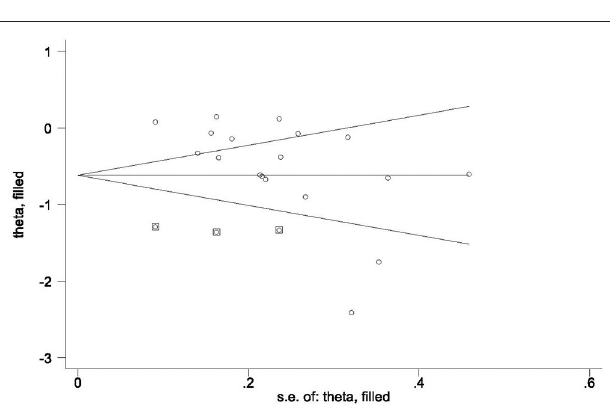
FIGURE 4 | Filled funnel plot to access potential publication bias of the negative affect studies ( n = 18). The circle and square with circle inside represent observed data (18 comparisons) and data added (three studies) by the trim-and-fill